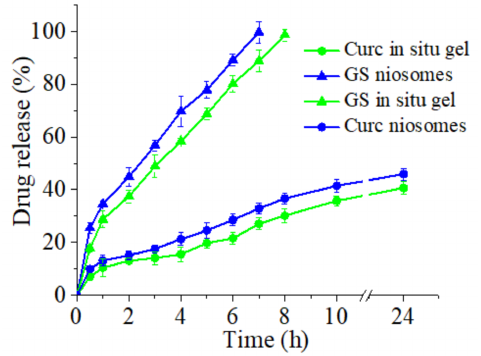
Figure 7. In vitro release profiles of Curc and GS from Curc/GS-co-loaded niosomes (S8) and from hybrid niosomal in situ gel (G7) in PBS (pH 6.5) at 37 ◦